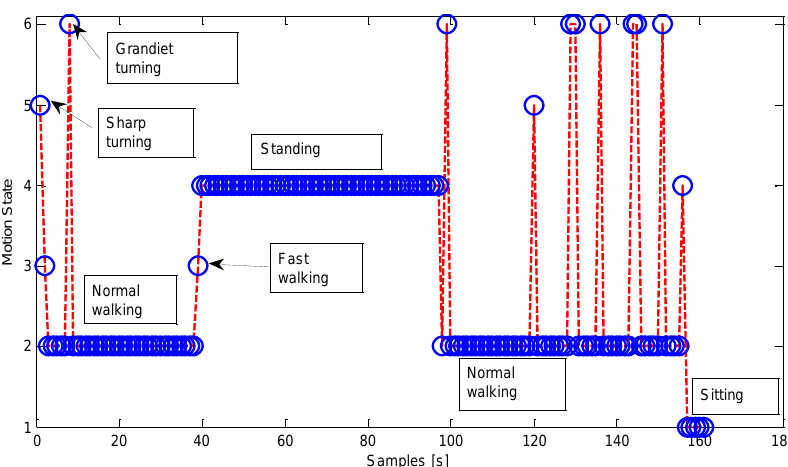
Figure 8. Motion states in fetching coffee context